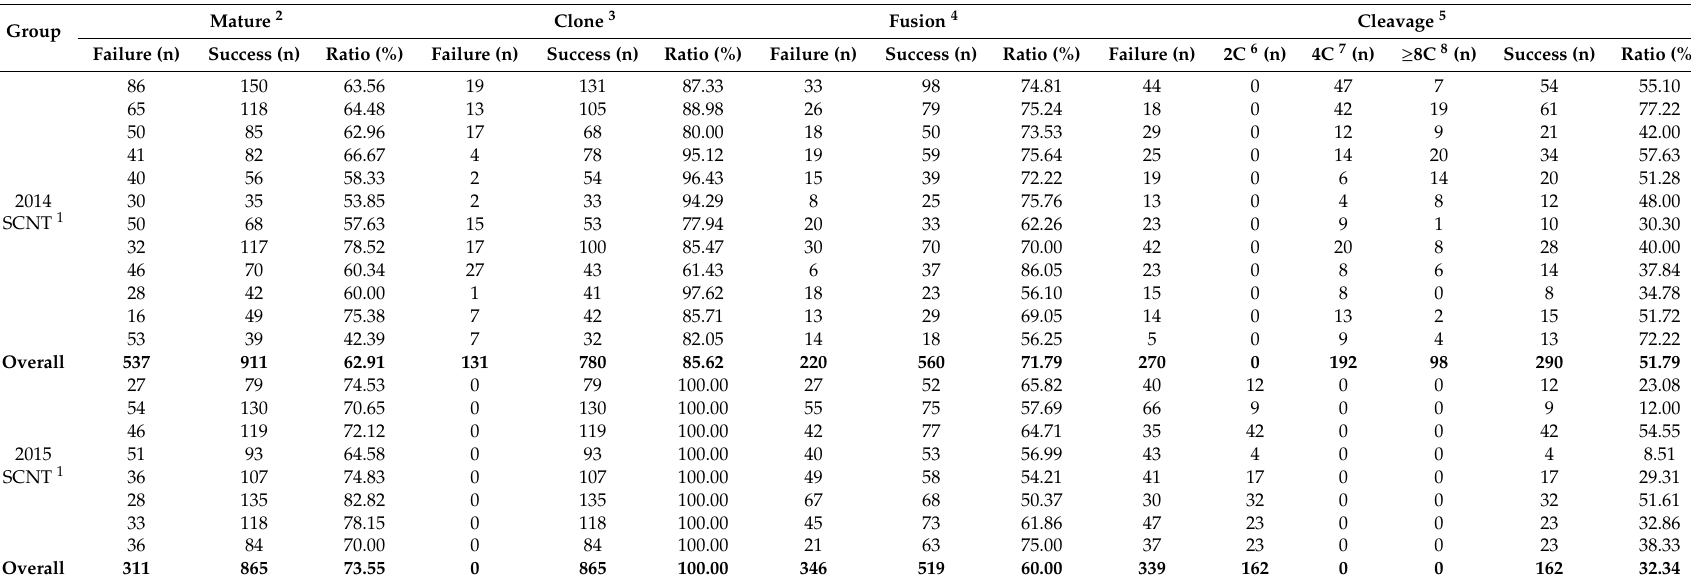
Table 2. F1-1 and F1-2 SCNT embryonic